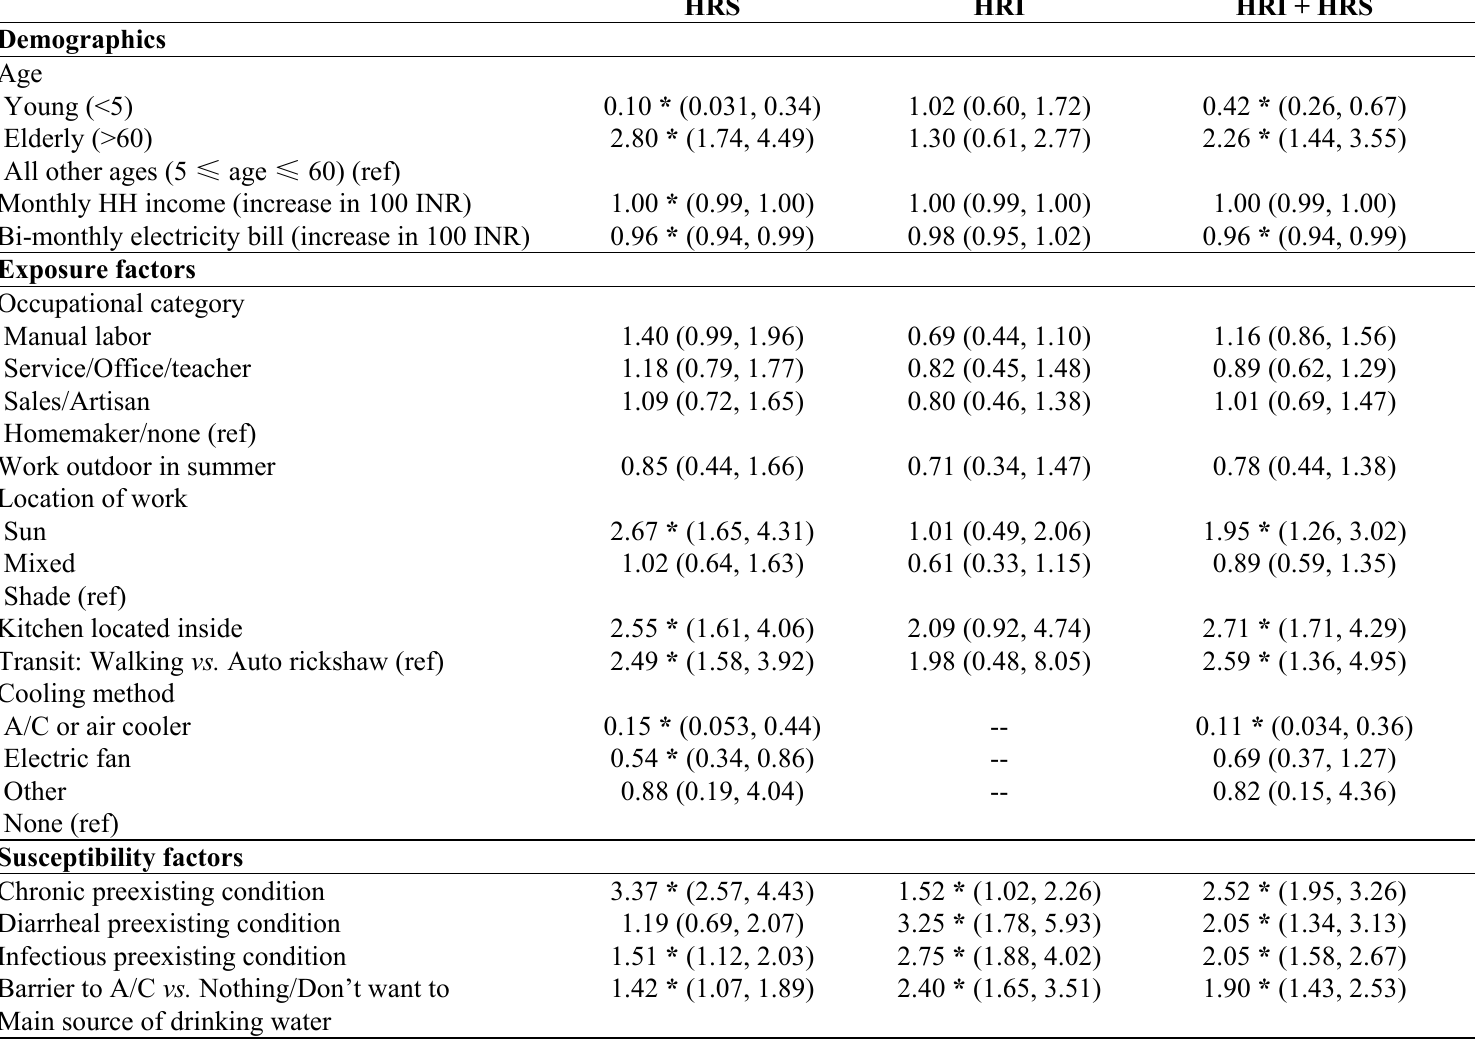
Table S4. Association between heat-related outcomes and candidate covariates (unadjusted ORs and 95% confidence intervals).